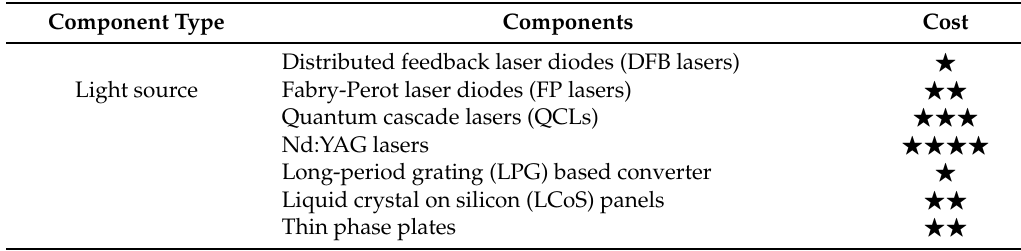
Table 9. Comparison regarding proposed sensor component costs for SDM sensing